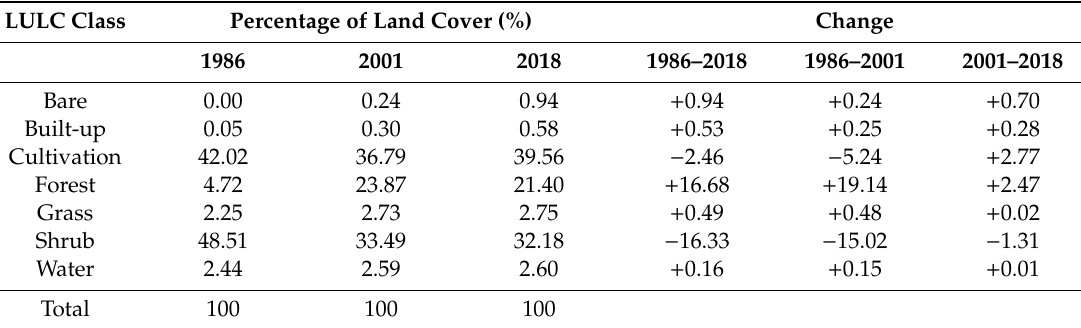
Table 5. Land use and land cover (LULC) dynamics of the dry Afromontane